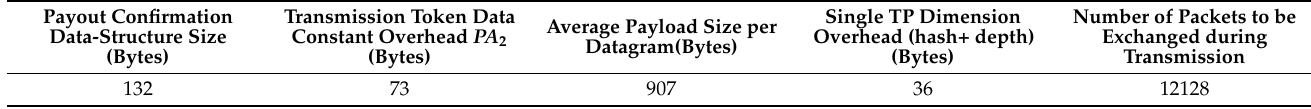
Table 1. Some of the significant simulation